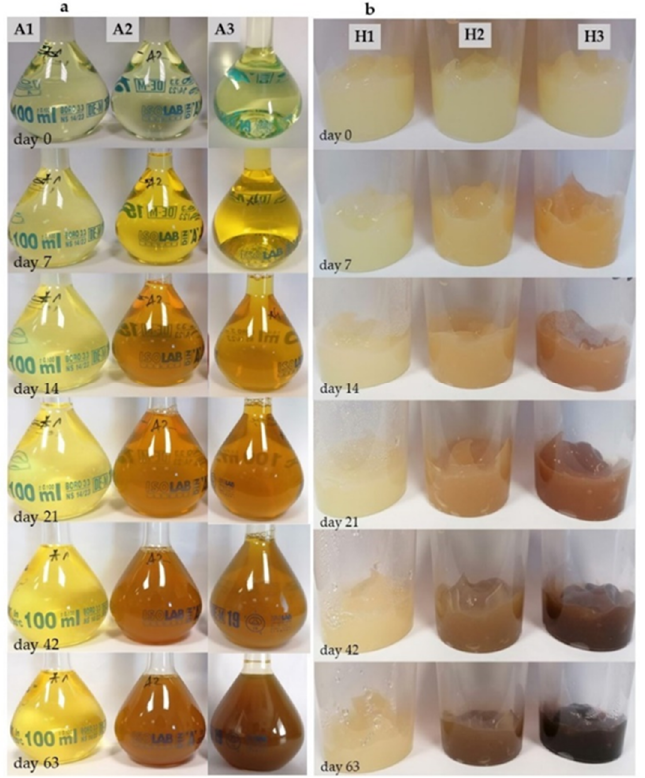
Figure 3. The course of colour changes within 63 days. ( a ) changes in aqueous solutions, ( b ) changes in hydrogel samples.